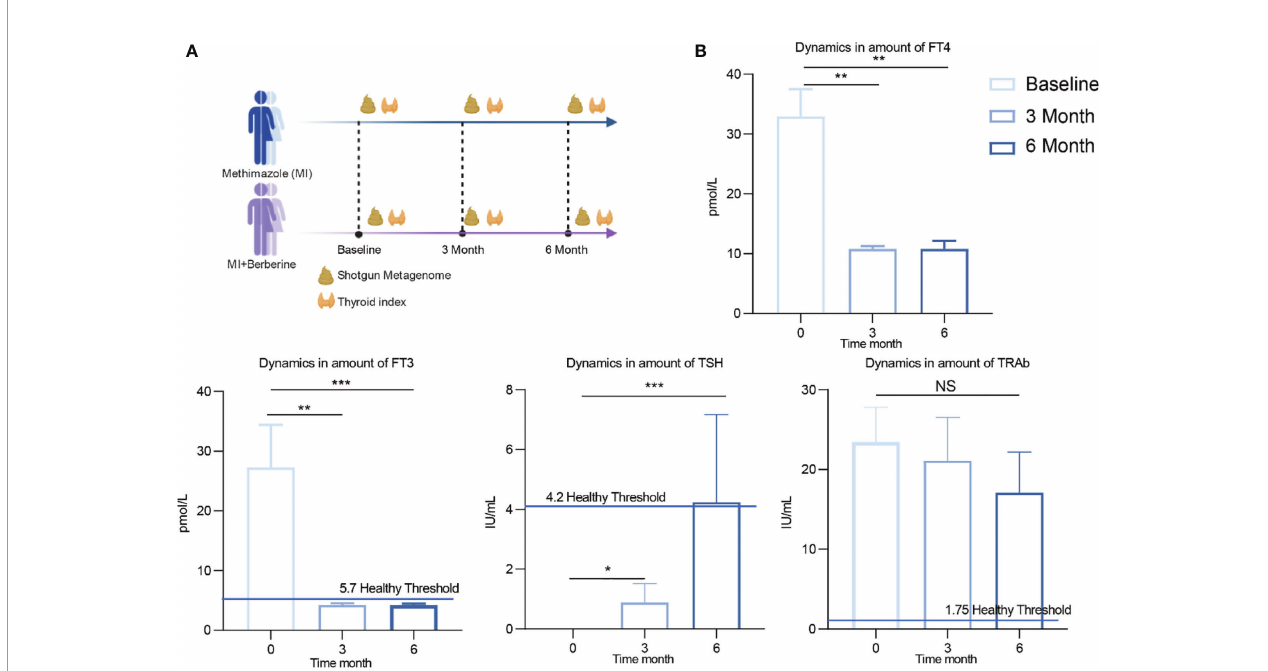
FIGURE 1 | Experimental design and changes of clinical indexes after treatment with methimidazole. (A) The study was divided into two groups, the methimazole treatment group ( n =8) and the combined methimazole and berberine treatment group ( n =10) both groups were treated for 6 months. Serum and stool samples were collected at baseline, 3 months and 6 months for measurement of thyroid parameters and shotgun metagenomic sequencing, respectively. (B) Concentrations of thyroid indicators such as free triiodothyronine (FT3), free thyroxine (FT4), thyroid stimulating hormone (TSH) and thyroid stimulating hormone receptor antibody (TRAb) at baseline, 3 months of treatment and 6 months of treatment. The differences in the levels of thyroid indicators between the two groups were compared using the Kruskal-Wallis test, and the differences between the two groups were statistically signi fi cant. Asterisks indicate signi fi cant differences between baseline and endpoints in the corresponding groups (***P < 0.001, **P < 0.01, *P < 0.05) NS means there is no signi fi cant difference between the two groups, error line means ± SEM